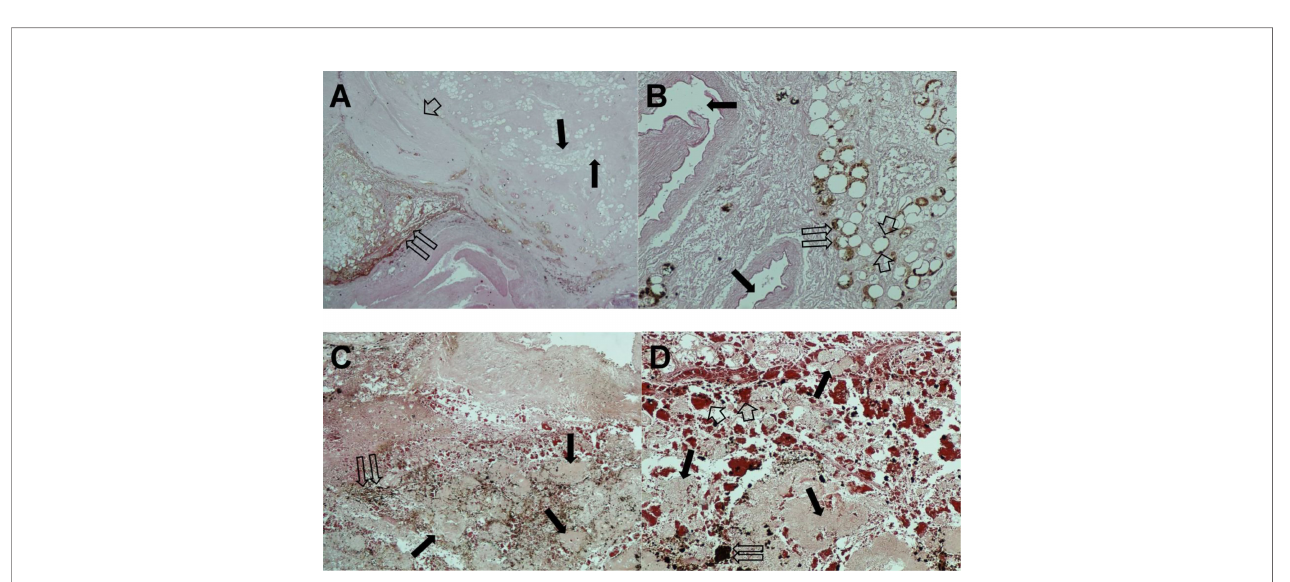
FIGURE 5 | Hematoxylin and eosin staining of pancreatic tissue sections. (A) Twin open arrows, necrotic tumor area; single thin arrows, fi brous and adipose replacement; short broad arrow, extensive fi brotic area (magni fi cation, ×100). (B) Twin open arrows, residual neoplastic glands with regressive phenomena; single thin arrows, major pancreatic ducts; short broad arrows, single pycnotic nuclei (magni fi cation, ×200). (C) The important regressive phenomena. Twin open arrows, hemosiderin deposits; single thin arrows, necrotic tumor area (magni fi cation, ×100). (D) Twin open arrows, hemosiderin deposit; single thin arrows, necrotic tumor area; short broad arrows indicate hemosiderin extravasation (magni fi cation, ×200).